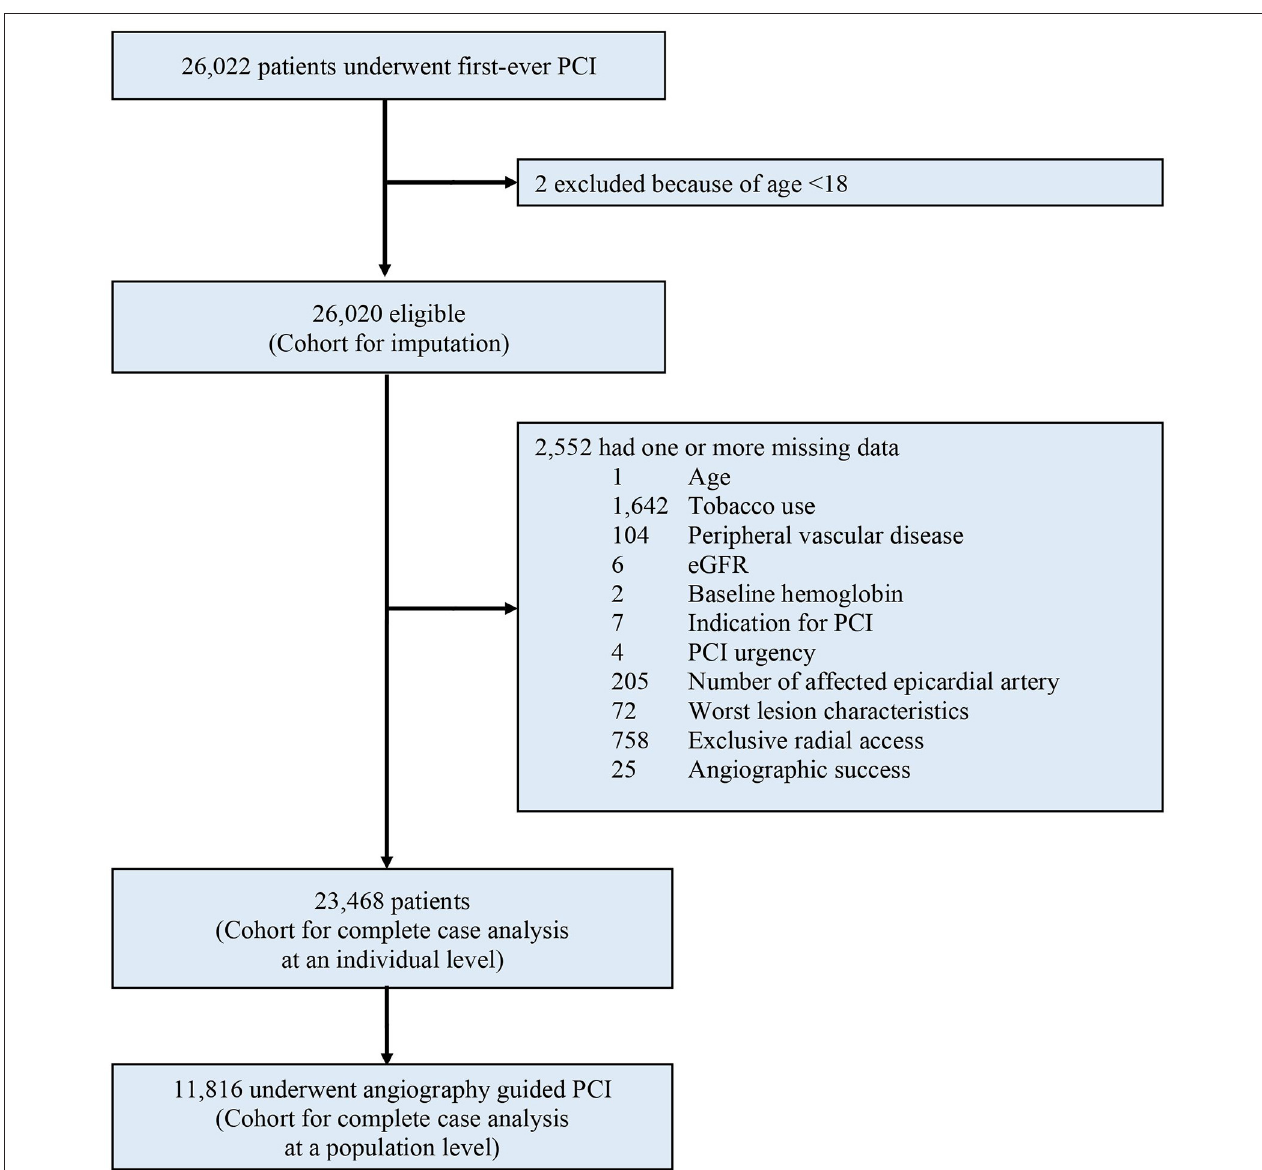
FIGURE 1 | Study profile. PCI, percutaneous coronary intervention; eGFR, estimated glomerular filtration